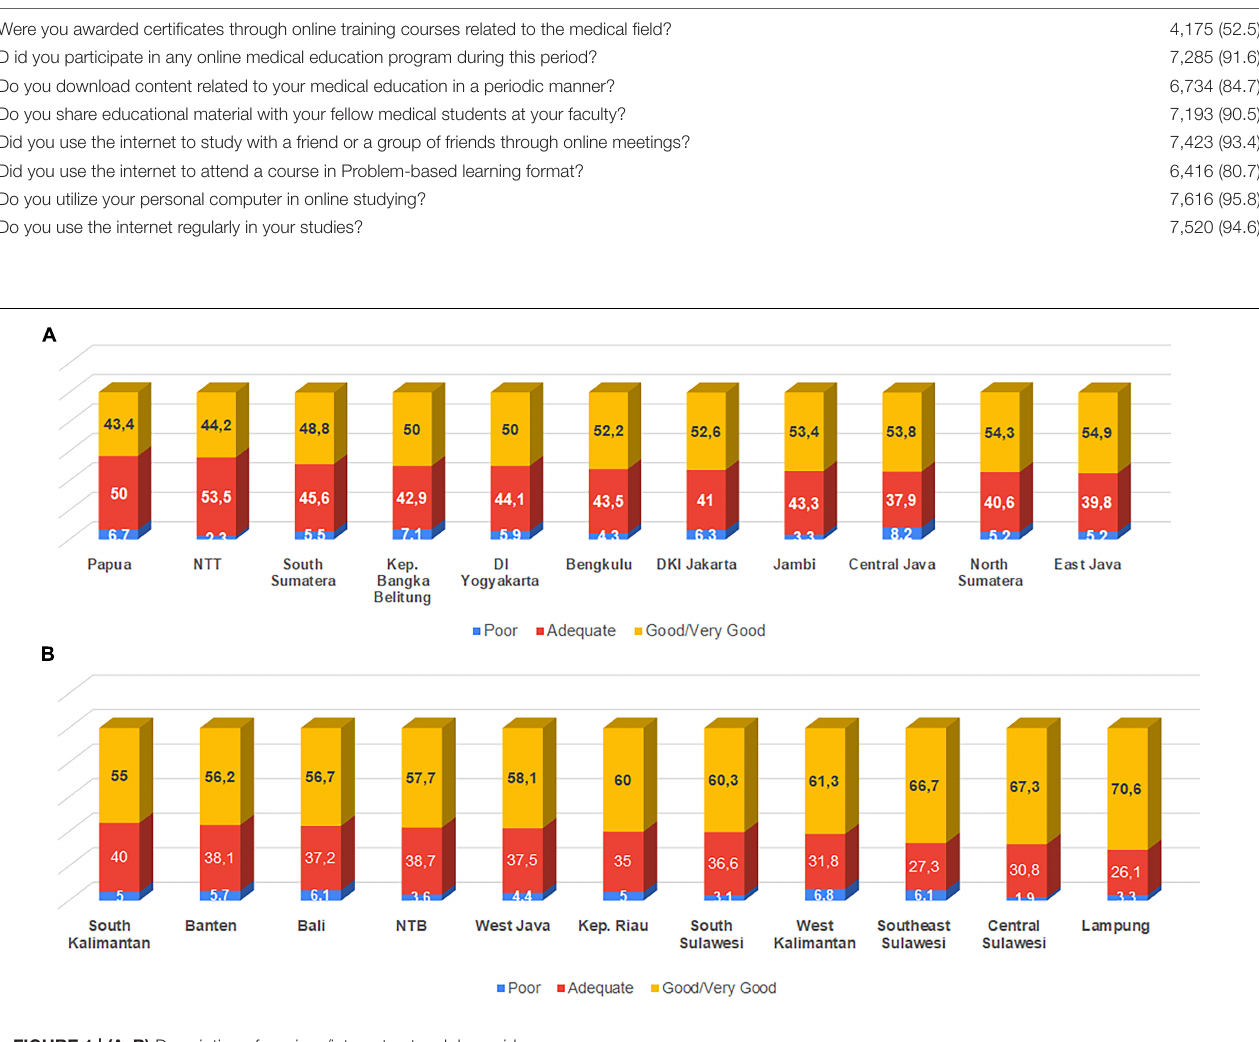
FIGURE 1 | (A–B) Description of services/internet network by residence.